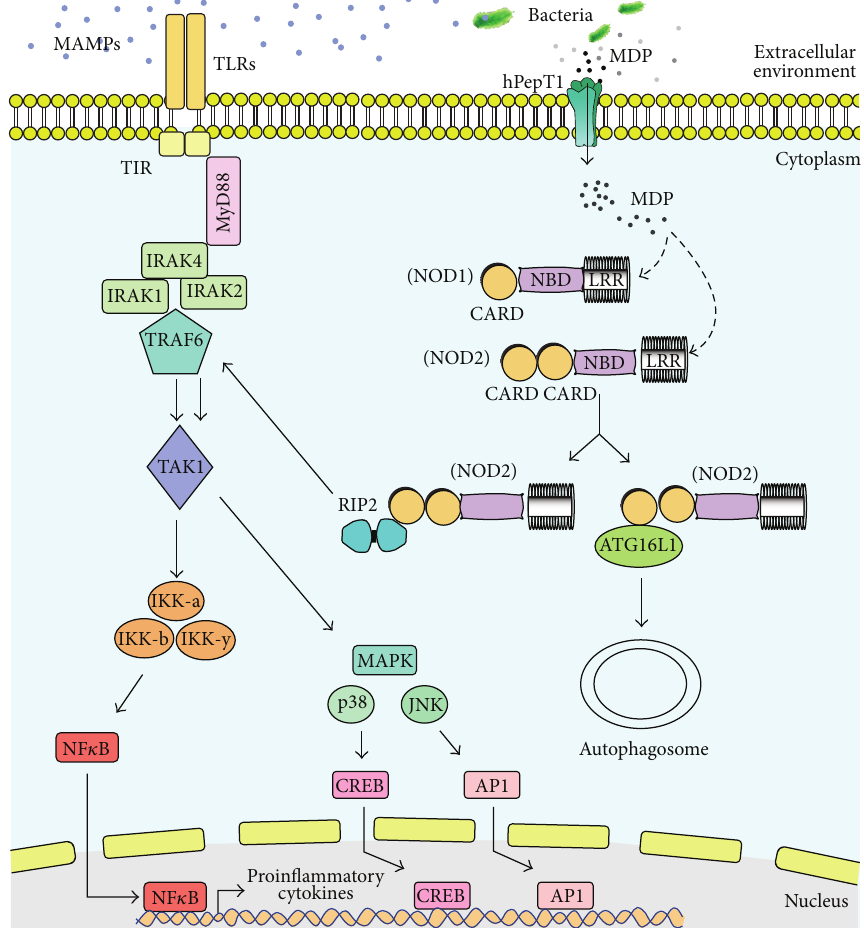
Figure2:TLRandNLRpathways.TheTLRpathwayiscomposedoftheconserveddomaintoll-IL-1-resistence(TIR),whichsensesmicrobial- associated molecular pattern (MAMPs) and interacts with the myeloid differentiation primary-response protein 88 (MyD88). MyD88 drives signaling through NF-kappa B, by interacting with the IL-1R-associated kinases 1, 2, and 4 (IRAK1, 2, and 4), TNF receptor-associated factor 6 (TRAF6), TGF- 𝛽 activated kinase 1 (TAK1), and the inhibitor of kappa B (IKKa, b, and y), promoting the activation of proinflammatory cytokines(left).TheNLRpathwaycanbeactivatedbybacterialmuramyldipeptide(MDP),interactingwiththeleucine-richrepeat-containing protein (LRR) present in NOD1 and NOD2 structures. Both NOD1 and NOD2 can interact with the adaptor molecule RICK (RIP2) via caspase recruitment domains (CARD-CARD) and stimulate TRAF6, which drives the activation of other elements of NF-kappa B and MAPK pathways, with the consequent production of proinflammatory cytokines (right). Additionally, NOD2 can interact with ATG16L1 and stimulate the formation of the